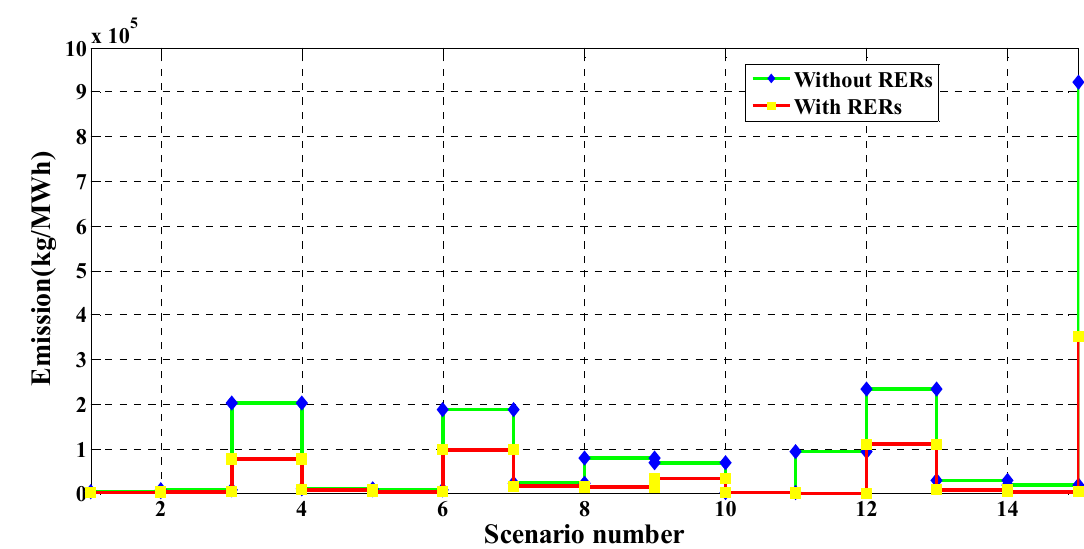
Figure 21. The 15-bus system emissions.